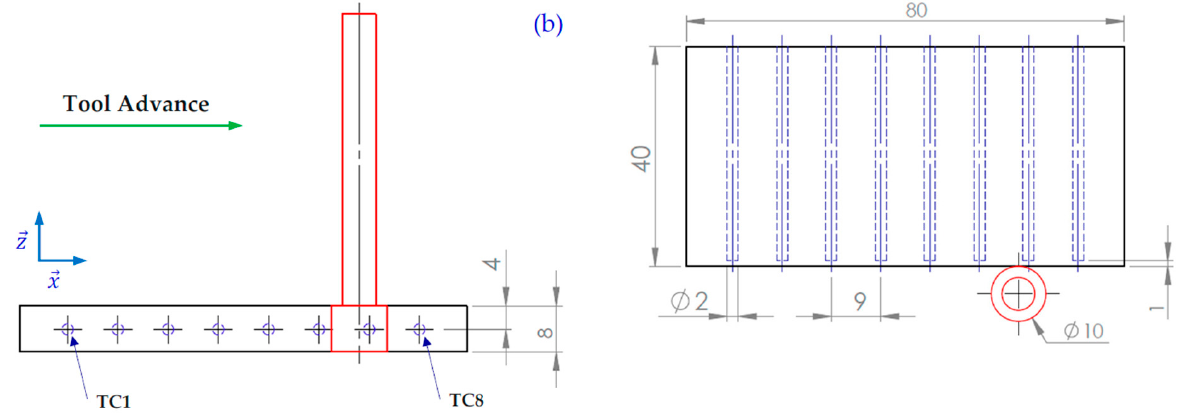
Figure 1. ( a ) Cutting configuration and temperature measurements technic, ( b ) Tool, Sample, and TCs probes holes geometries.